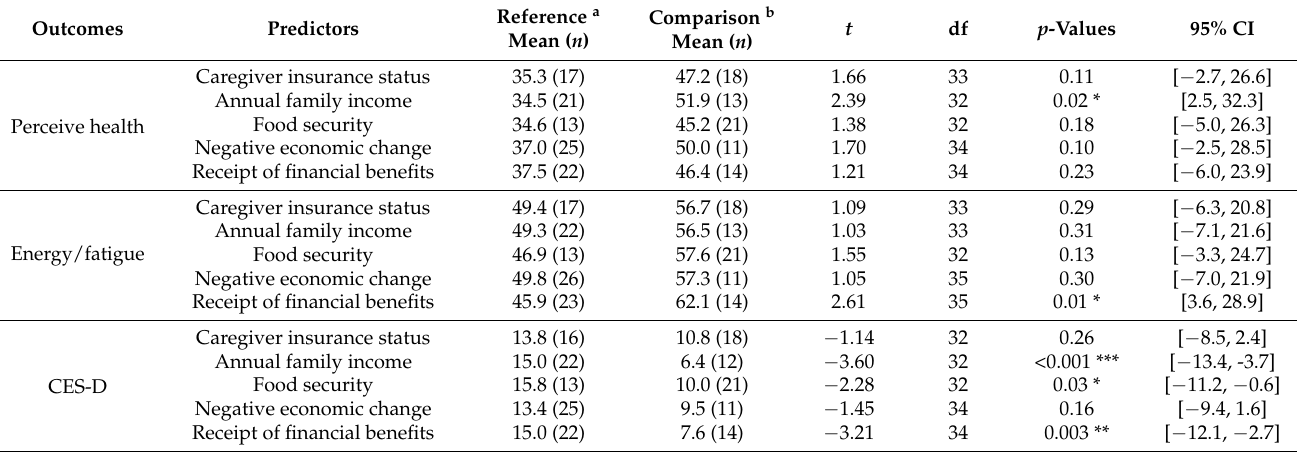
Table 5. Independent samples t -tests